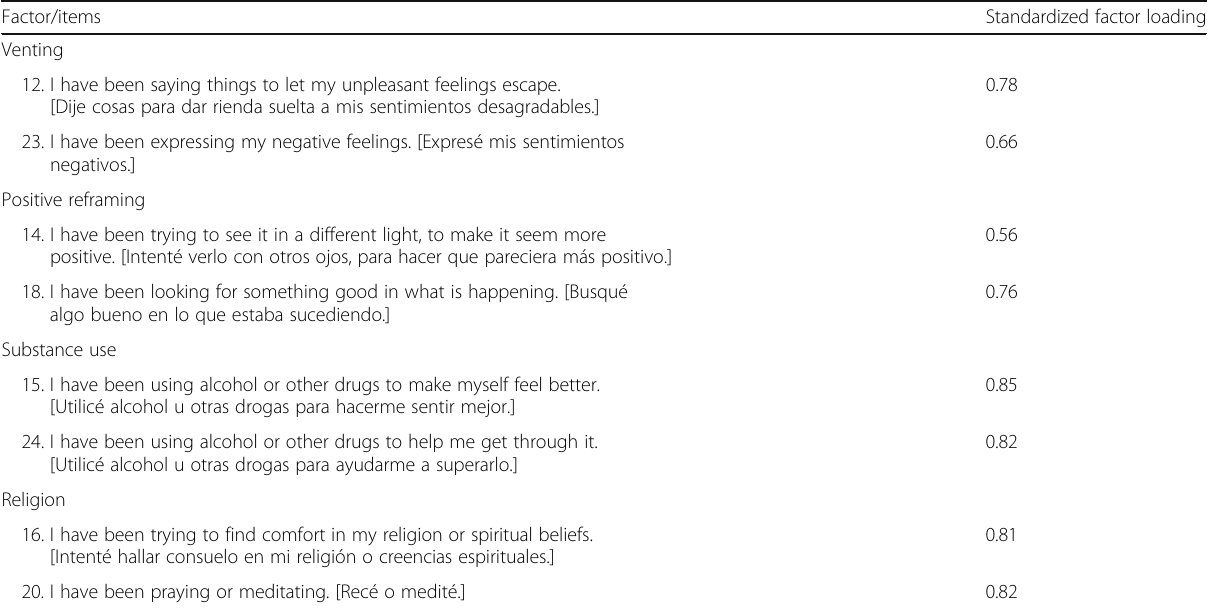
Table 3 Factors, items, and standardized factor loadings for model 1 ( n = 1847) (Continued)